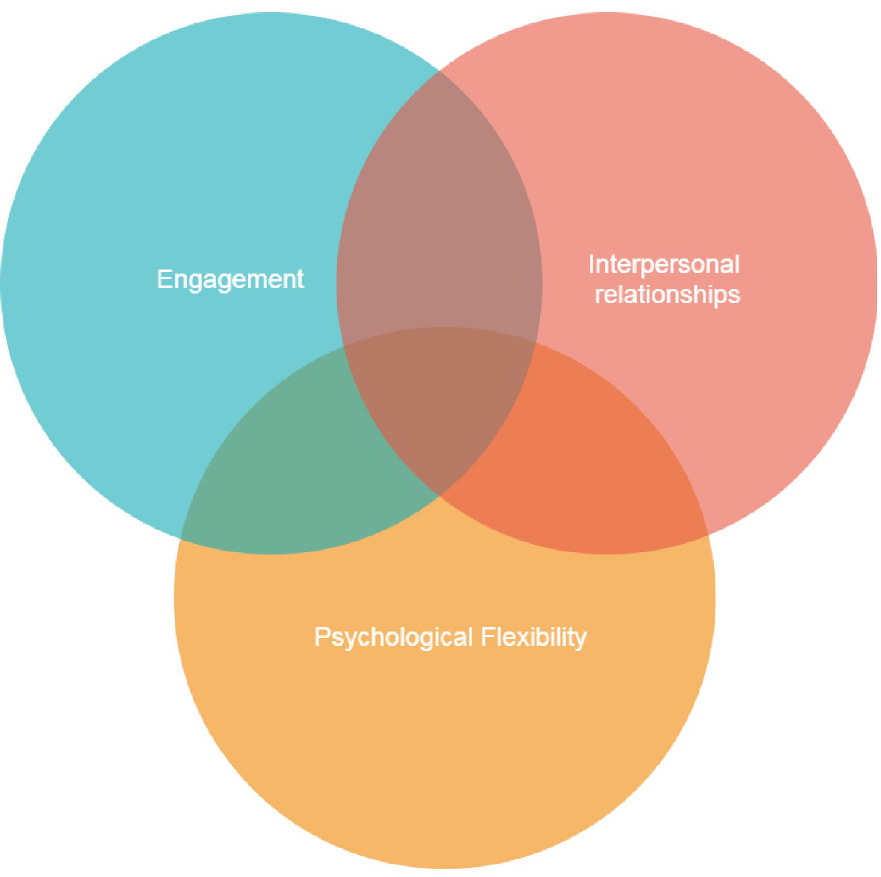
Fig 3. MENTOR intervention